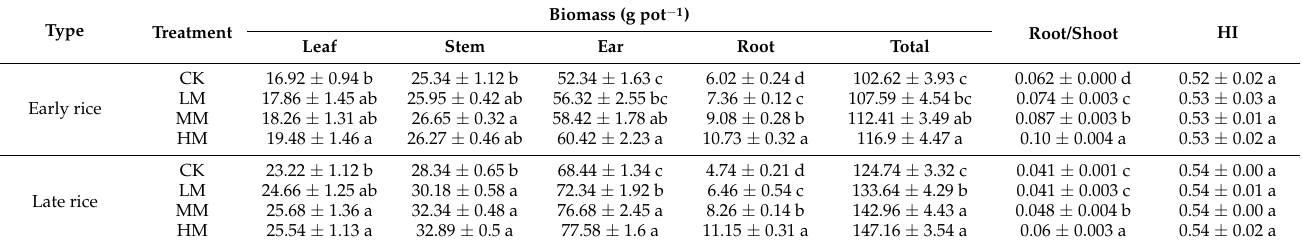
Table 3. Biomass of double cropping rice of different treatments at maturity